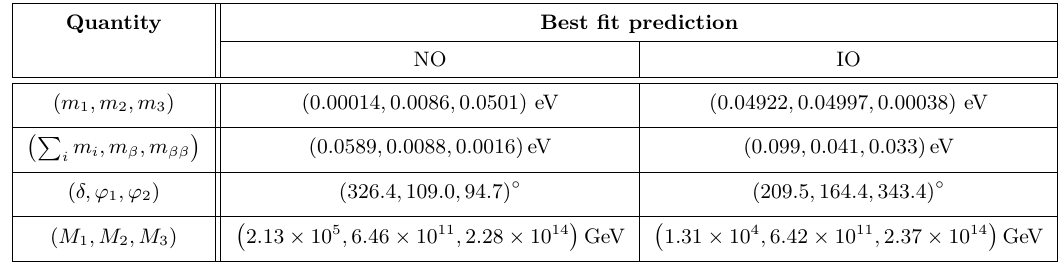
Table 2 . Best fit predictions of several quantities in the neutrino sector. We have defined pP the Dirac phase. Here m β = | U ei | 2 m 2 is the effective mass parameter for beta decay and i i m ββ = | P U 2 m i | is the effective mass parameter for neutrinoless double beta ei i